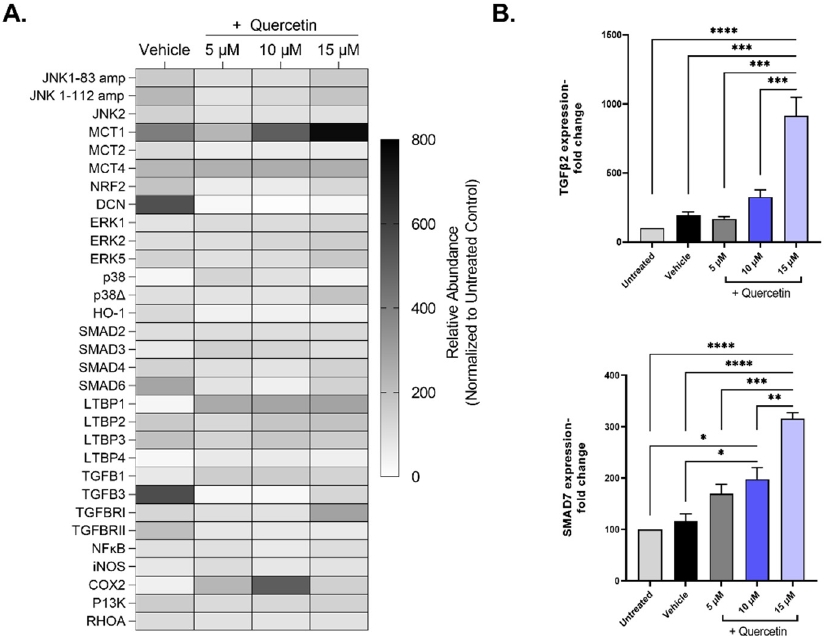
Figure 6. Expression of select mRNA transcripts by primary human corneal fibroblasts in 3D con- structs treated with increasing concentrations of quercetin compared to untreated and vehicle-treated cultures. ( A ) Heat map of relative gene expression detected using qRT-PCR analysis. Expression was normalized to the untreated control and presented as a percentage (untreated control set at 100%). ( B ) Select genes influenced by quercetin treatment: transforming growth factor- β 2 (TGFB2) mothers and against decapentaplegic homolog 7 (SMAD7). Statistical significance determined based on an ordinary one-way ANOVA analysis with Šídák’s multiple comparisons test. Bars represent mean ± standard error of the mean with n = 3. * p < 0.05, ** p < 0.01, *** p < 0.005, and **** p < 0.0001.